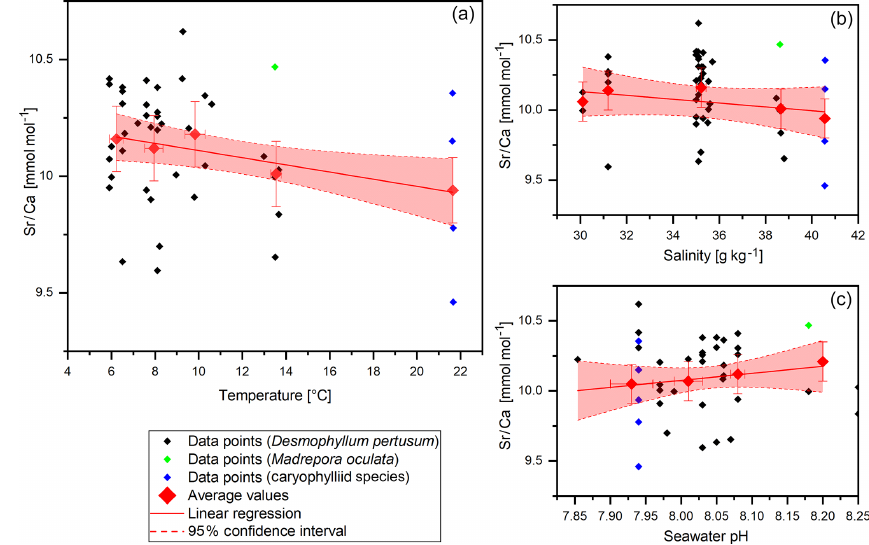
Figure 5. Sr / Ca data (without COC) plotted against water temperature, salinity and pH. Red diamonds indicate averaged values for temper- ature ranges. Temperature ranges are 5–7, 7–9, 9–11, 13–15 and 21–23 ◦ C. The x error relates to the SD of the temperature/salinity mean. The y error bars indicate 2SD of the JCp-1 mean. Red lines are linear regressions of the averaged values with the 95% confidence interval